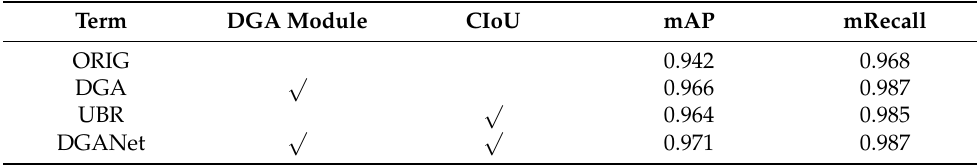
Table 3. Performance of combining DGA and UBR.